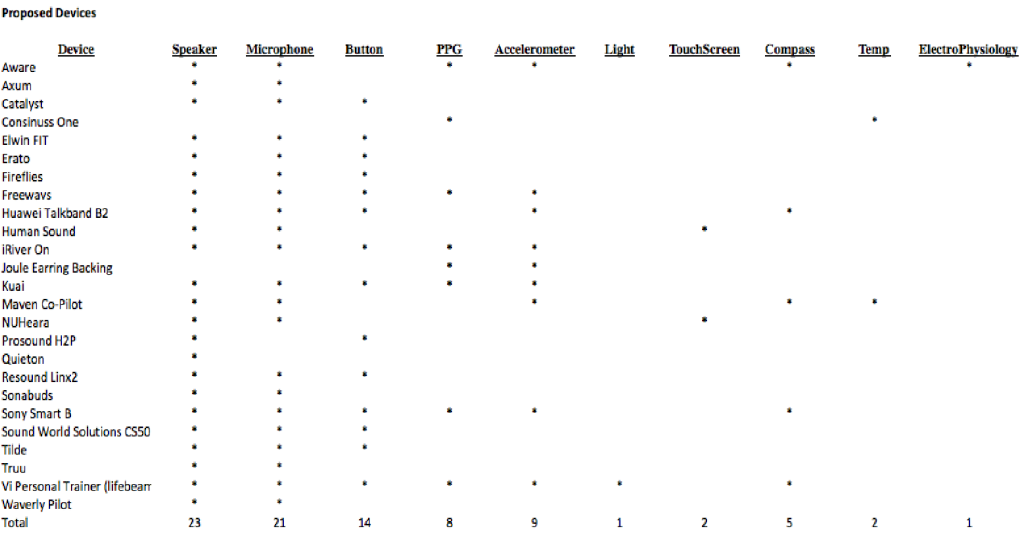
Figure 2. List of hearables devices, and their associated features, that are currently available.